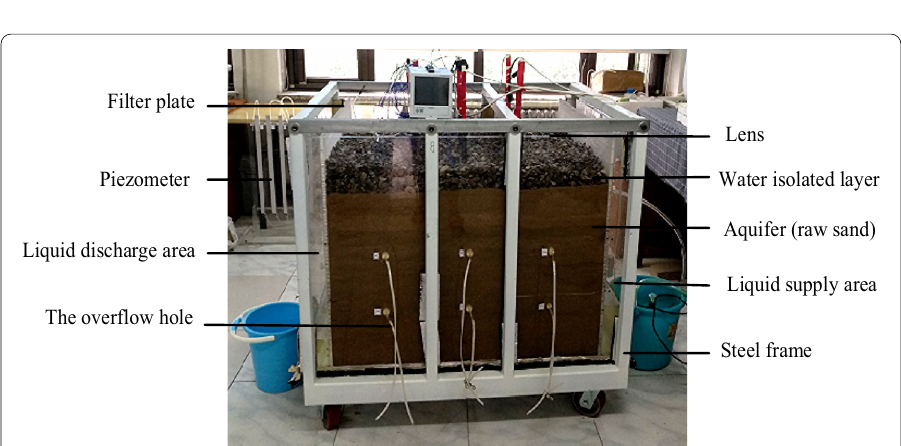
Fig. 5 Photograph of the infiltration